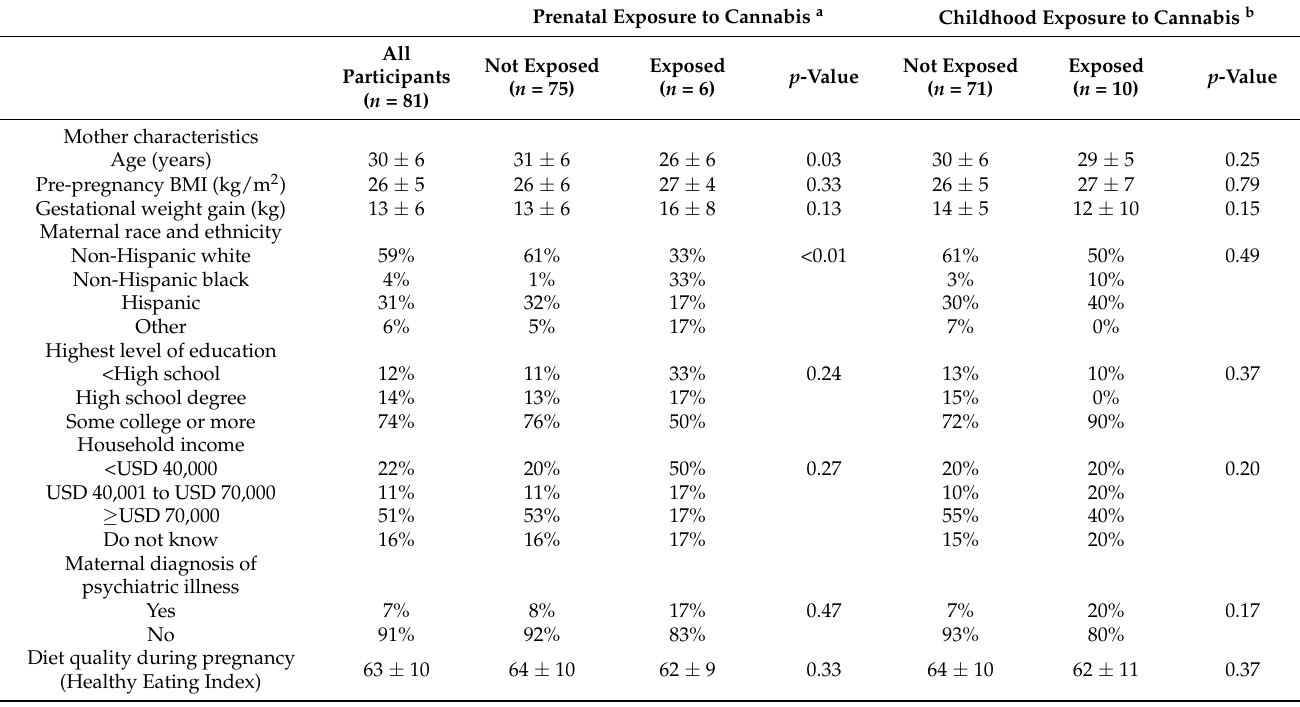
Table 1. Characteristics of mother–child pairs by prenatal or childhood exposure to cannabis. Prenatal Exposure to Cannabis a Childhood Exposure to Cannabis b All Not Exposed Participants ( n =